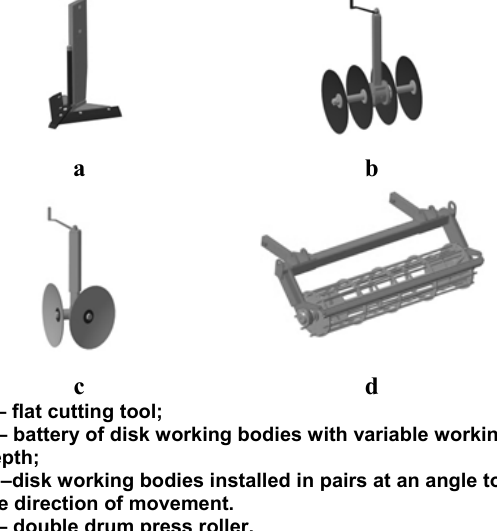
Figure 4. Strain gauge